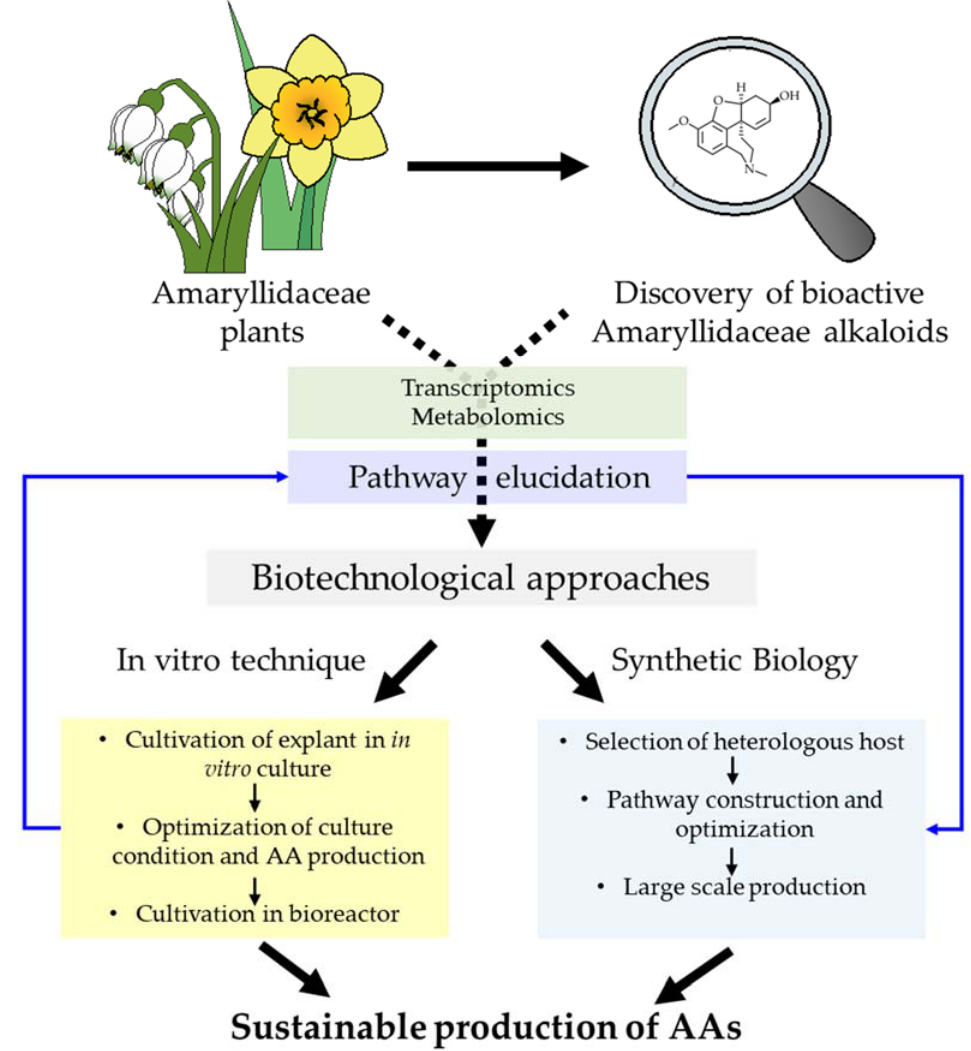
Figure 1. Current and future biotechnological approaches to produce Amaryllidaceae alkaloids.